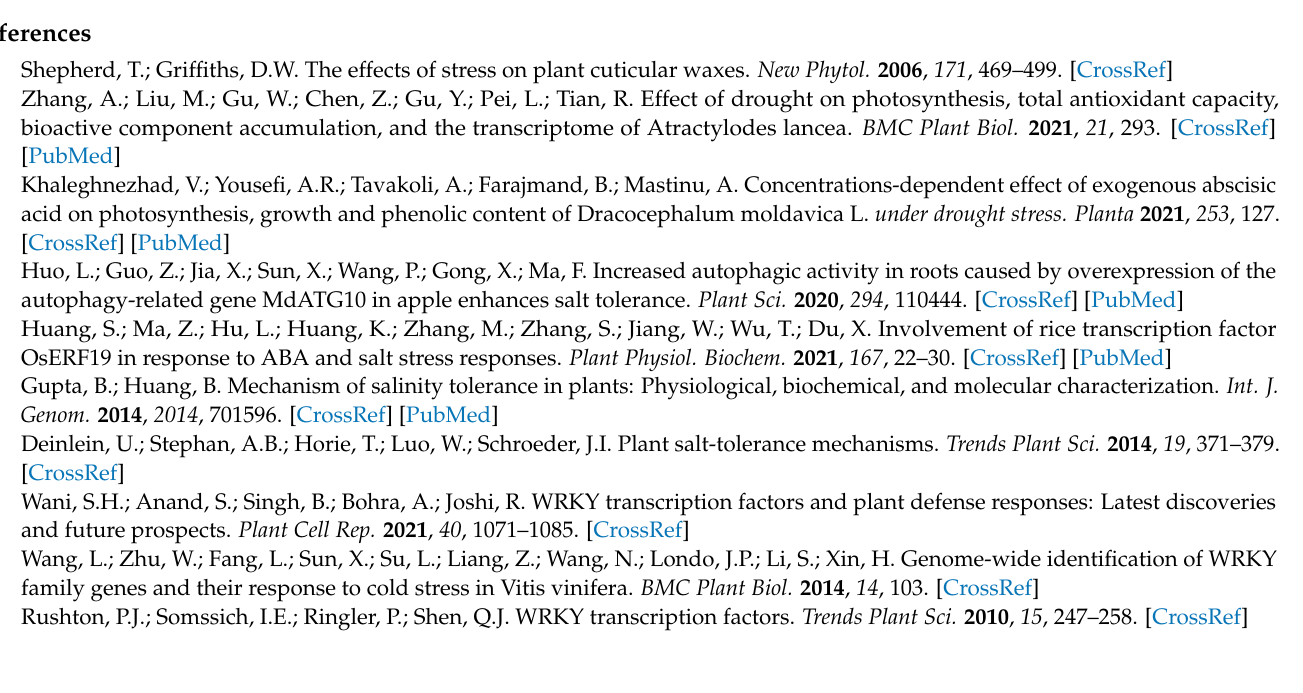
Table S2: Synteny relationship of WRKY genes between Arabidopsis and M. domestica; Table S3: Con- served motifs found in the MdWRKY proteins via MEME; Figure S1: Multiple alignment of MdWRKYs in group I. Only the highly conserved and less conserved amino acid positions were highlighted based on the relative entropy threshold of the residue. Only alignment positions with no gaps will be colored. Red box indicated highly conserved positions and blue box indicated lower conservation, grey box indicated nonconserved positions, and red line indicated gaps; Figure S2: Multiple alignment of MdWRKYs in group II. Only the highly conserved and less conserved amino acid positions were highlighted based on the relative entropy threshold of the residue. Only alignment positions with no gaps will be colored. Red box indicated highly conserved positions and blue box indicated lower conservation, grey box indicated nonconserved positions, and red line indicated gaps; Figure S3: Multiple alignment of MdWRKYs in group III. Only the highly conserved and less conserved amino acid positions were highlighted based on the relative entropy threshold of the residue. Only alignment positions with no gaps will be colored. Red box indicated highly conserved positions and blue box indicated lower conservation, grey box indi- cated nonconserved positions, and red line indicated gaps; Figure S4: Identification of transgenic tobacco plants. (A) PCR analysis of the regenerated tobacco by gene specific primers. (B) Expression analysis of MdWRKY70L in the transgenic tobacco and wild type